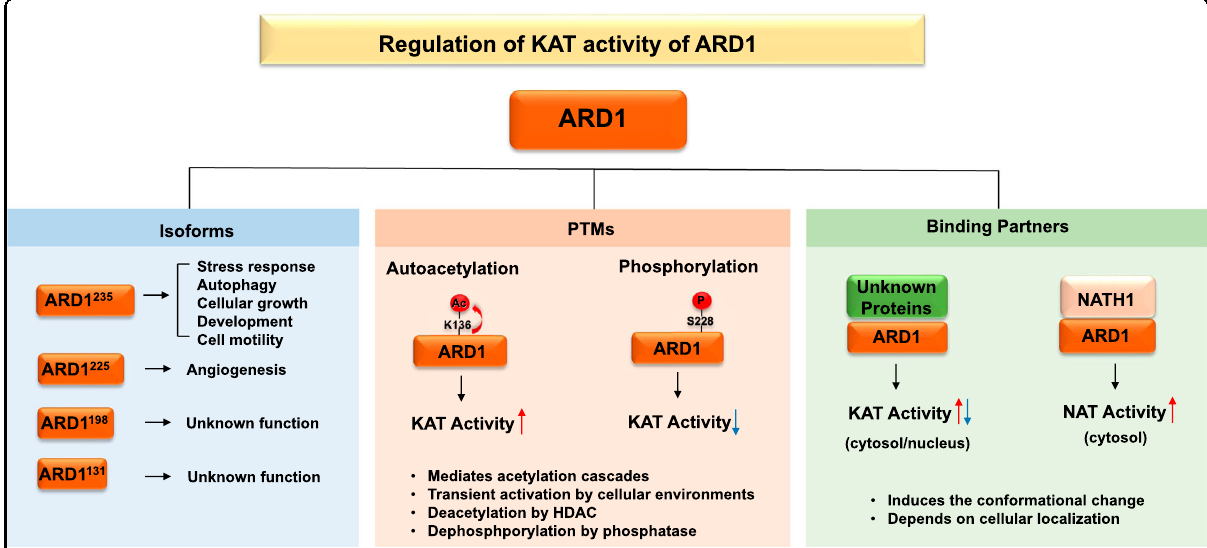
Fig. 2 Regulation of the KAT activity of ARD1. The KAT activity of ARD1 is regulated by PTMs. While autoacetylation at the K136 residue stimulates the KAT activity of ARD1, phosphorylation at the S228 residue inhibits the KAT activity of ARD1. Autoacetylation is conserved among ARD1 isoforms, including ARD1 235 and ARD1 225 ; however, autoacetylation regulates differential cellular functions depending on the isoform. While the autoacetylation of ARD1 235 enhances cellular growth, the autoacetylation of ARD1 225 inhibits angiogenesis. The KAT activity of ARD1 might also